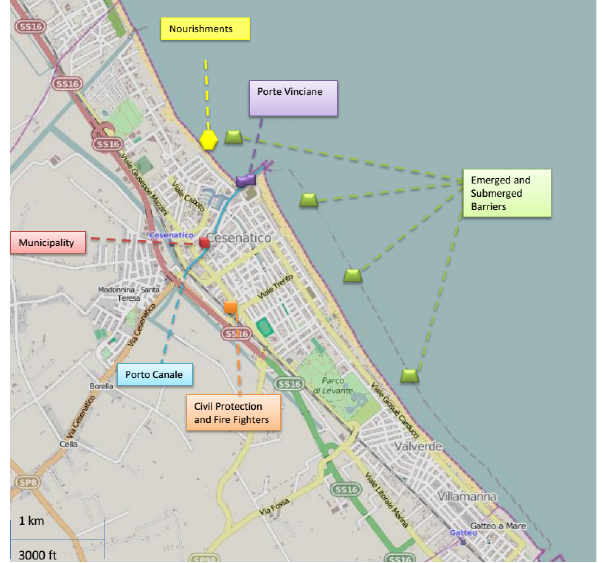
Figure 2. Map of Cesenatico. We highlighted the location of the Porto Canale , the municipality and the key emergency actors (civil protection and fire fighters). Furthermore, we included the location of some of the structural defences and sand nourishments (source: our elaboration from Open Street